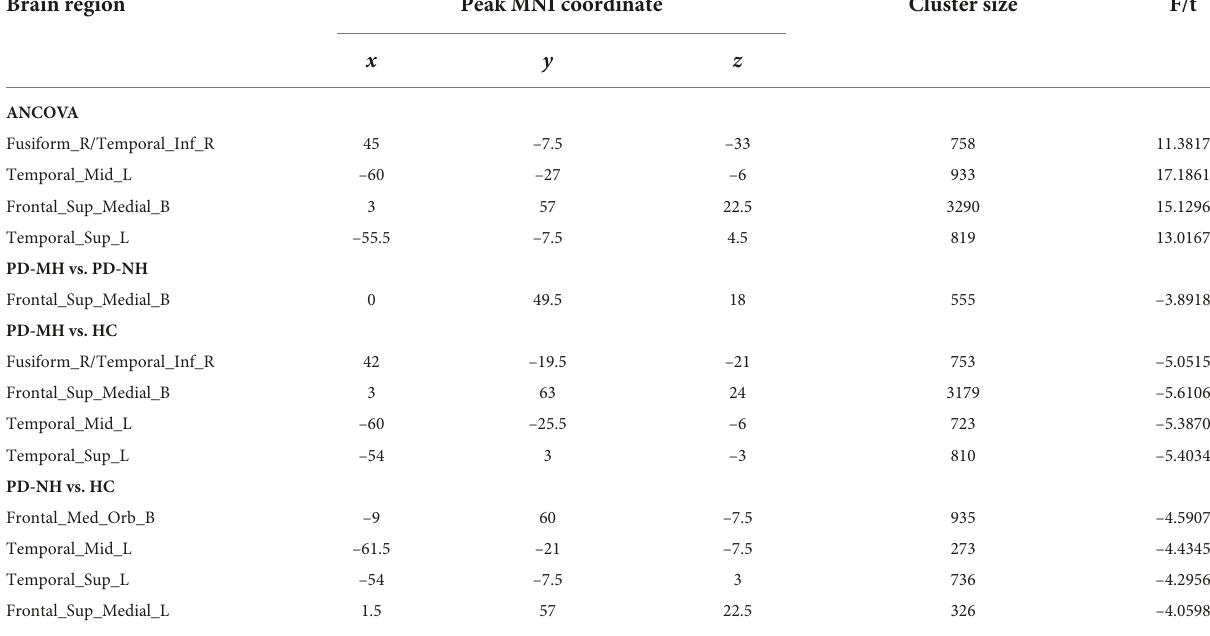
TABLE 2 Comparison of gray matter volume in PD-MH group, PD-NH group, and HC group. Brain region